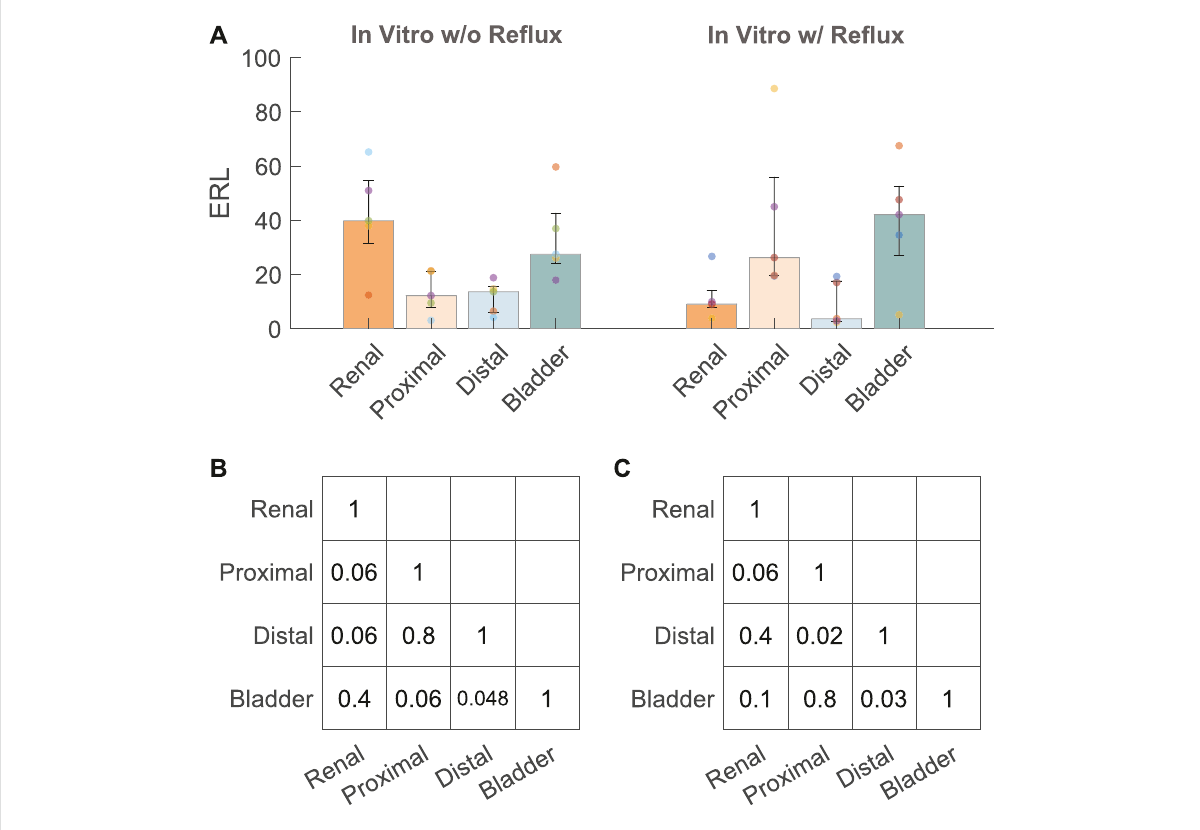
FIGURE 4 (A) ERLresultsfromthe invitro experimentswith(w/)andwithout(w/o)re fl ux.ThesizeofthebaranderrorbararegivenbythemedianandIQR, respectively. Corrected p values of complete comparisons between each section of the stent are given for the test group without re fl ux (B) and with re fl ux (C) .